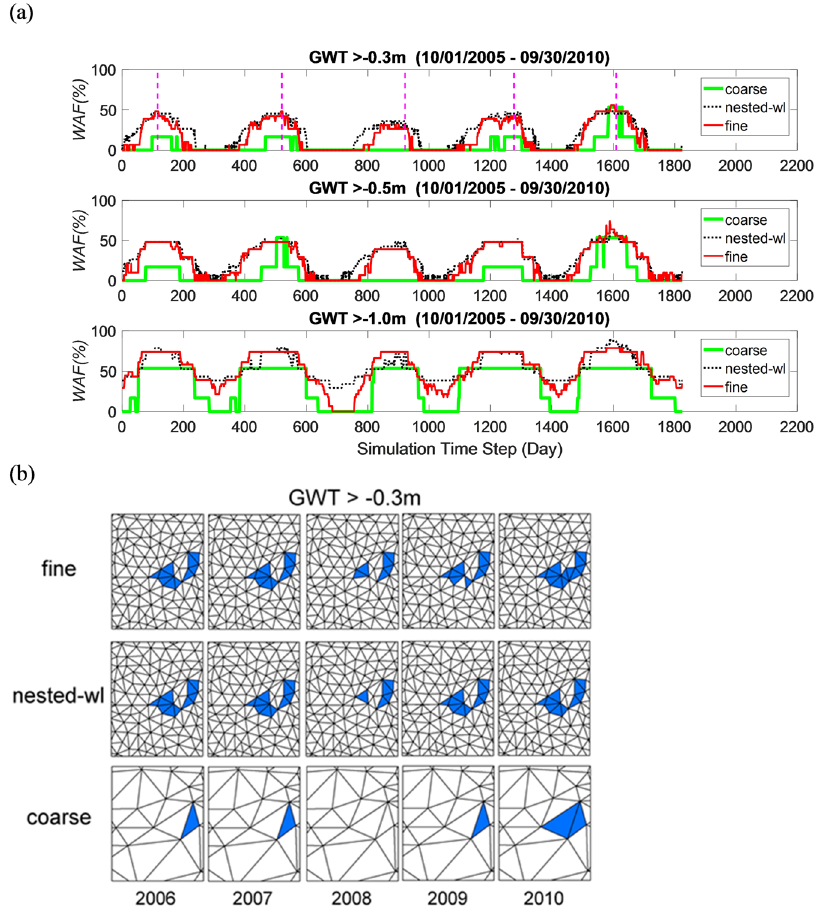
Figure 6. Comparison of modeled WAF under three groundwater depth thresholds ( a ) and spatial distribution of wet elements ( b ) for GWT > − 0.3 m at the times identified by vertical hatched lines in the topmost panel of ( a